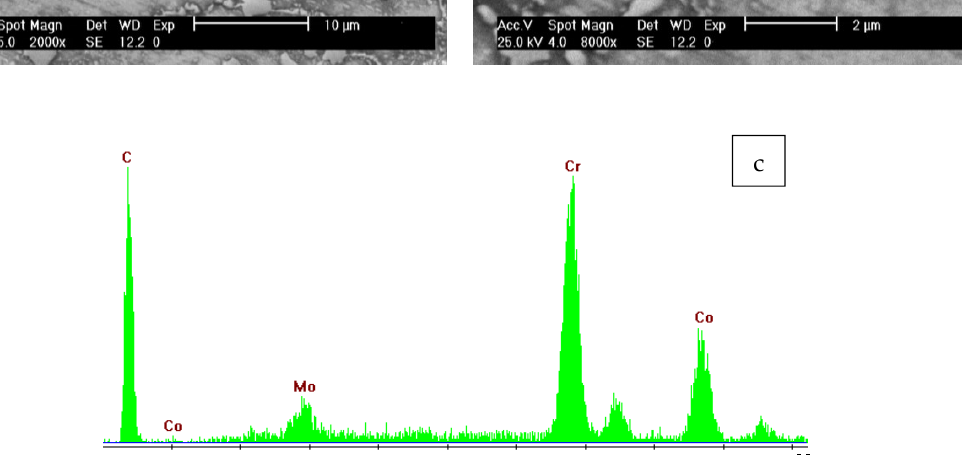
Figure 1. SEM micrographs of ( a ) the partial solution sample and ( b ) undissolved primary carbides. ( c ) EDS point analysis of the precipitated carbide.